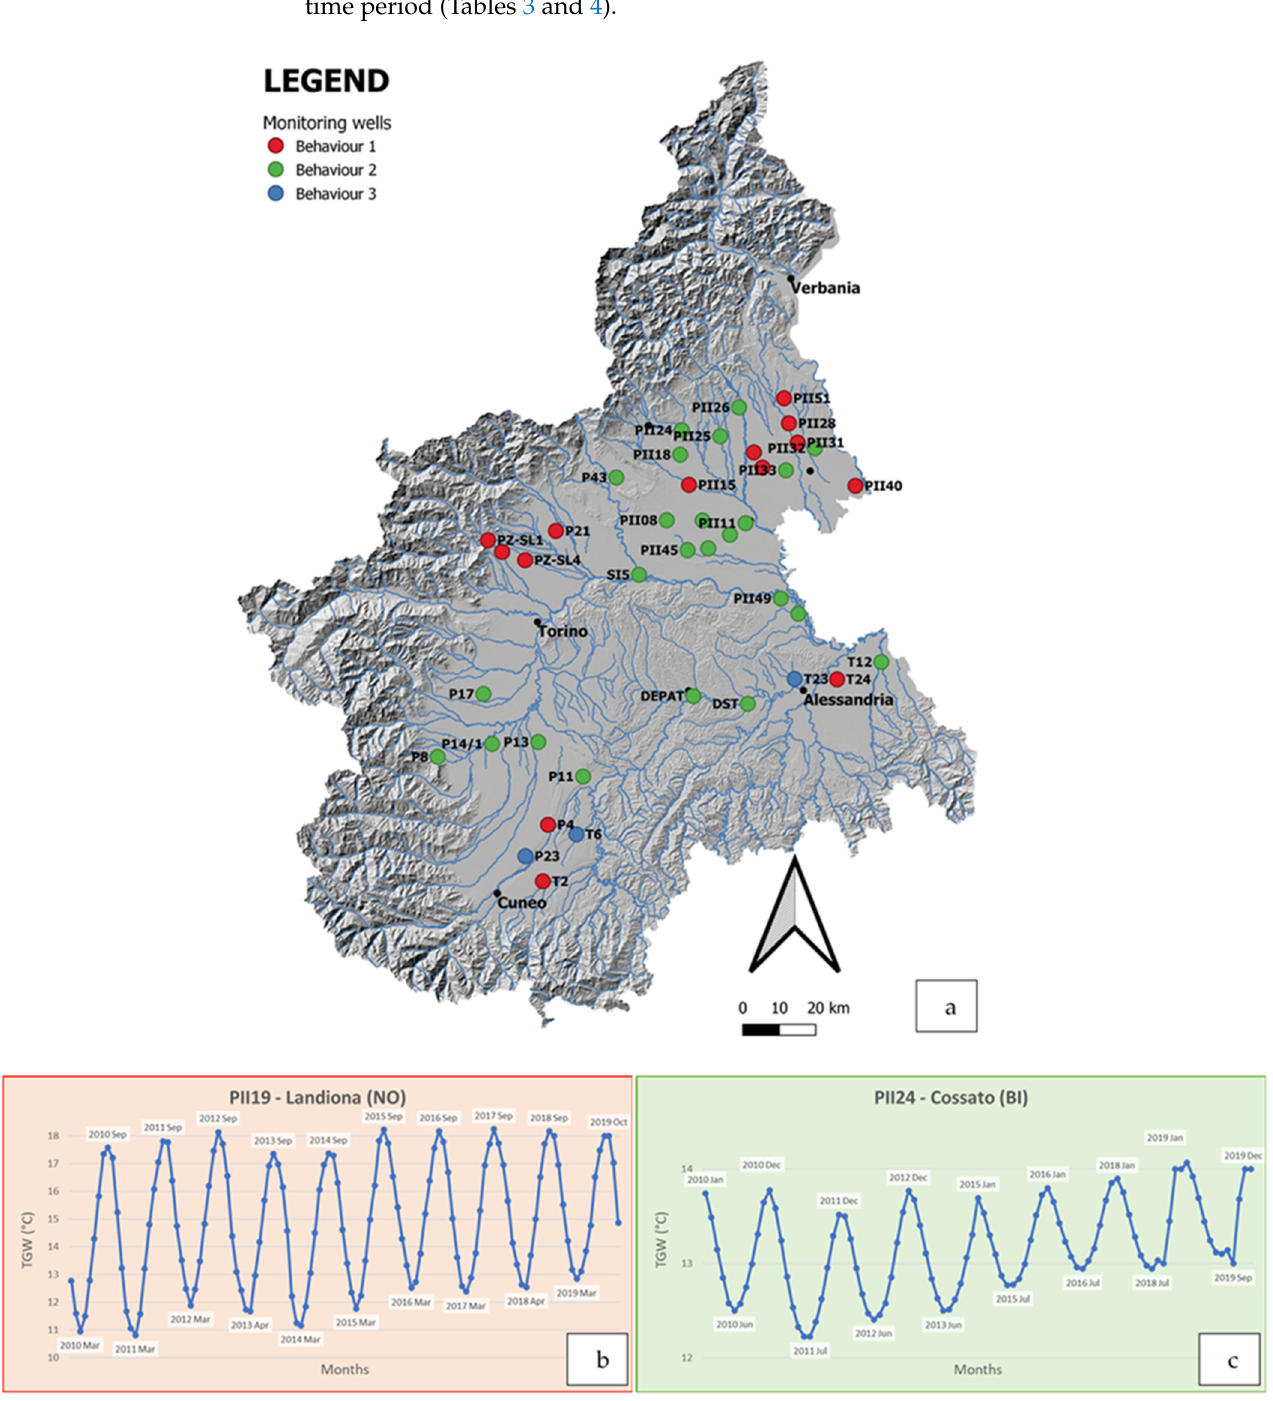
Figure 3. Maximum and minimum GWT peak behaviours throughout the whole Piedmont Po plain. ( a ): distribution of the monitoring wells highlighting different behaviours. ( b ): example of behaviour 1 (maximum in autumn and minimum in spring). ( c ): example of behaviour 2 (maximum in winter and minimum in summer).